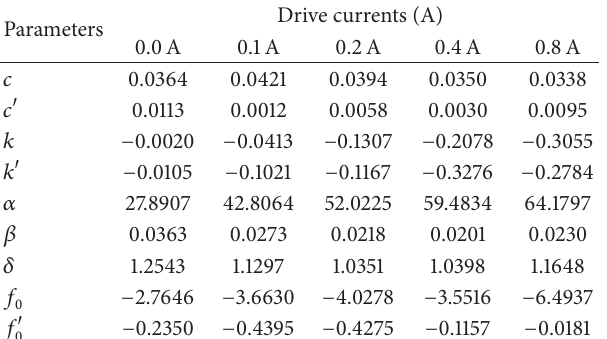
Table 2: Identified model